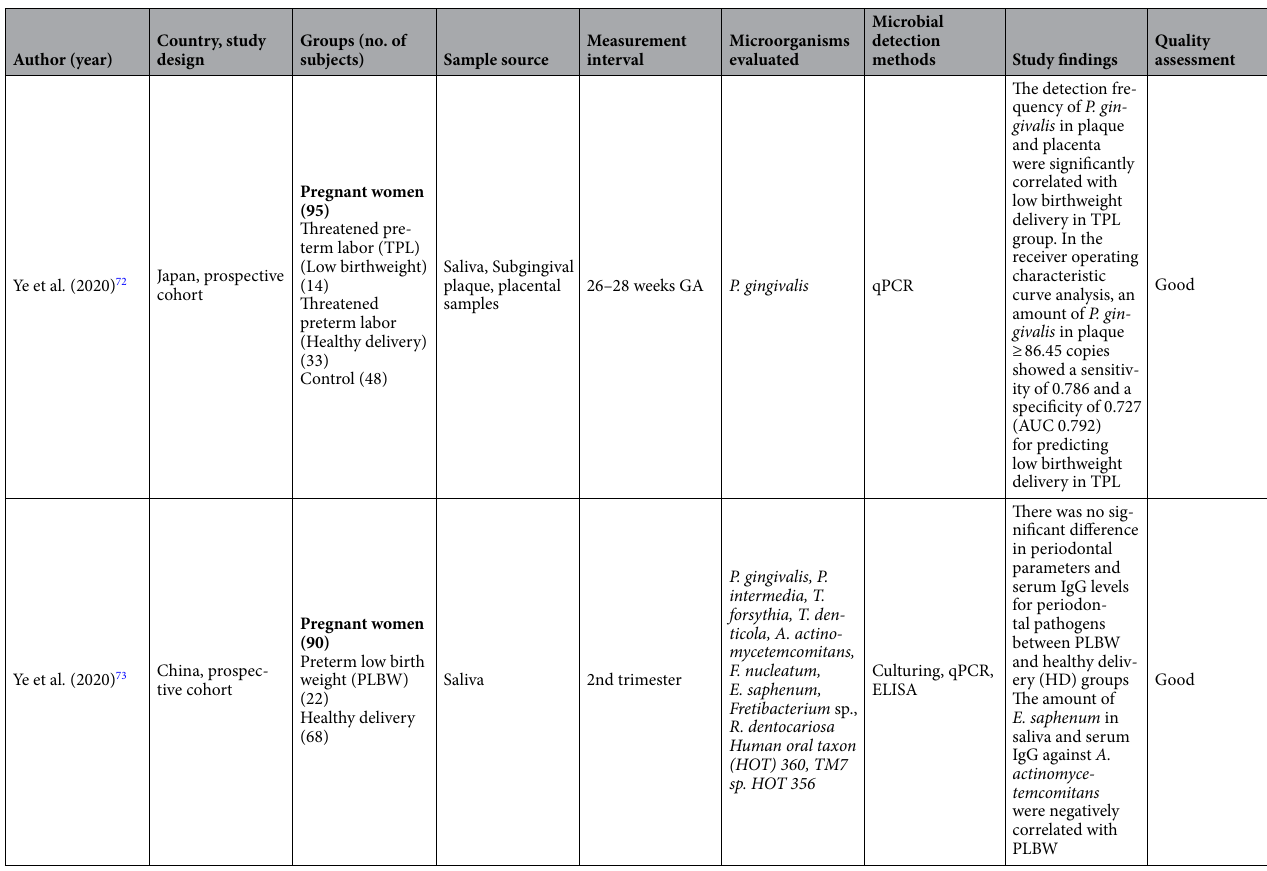
Table 4. Association between oral microorganisms during pregnancy and adverse birth outcome—preterm